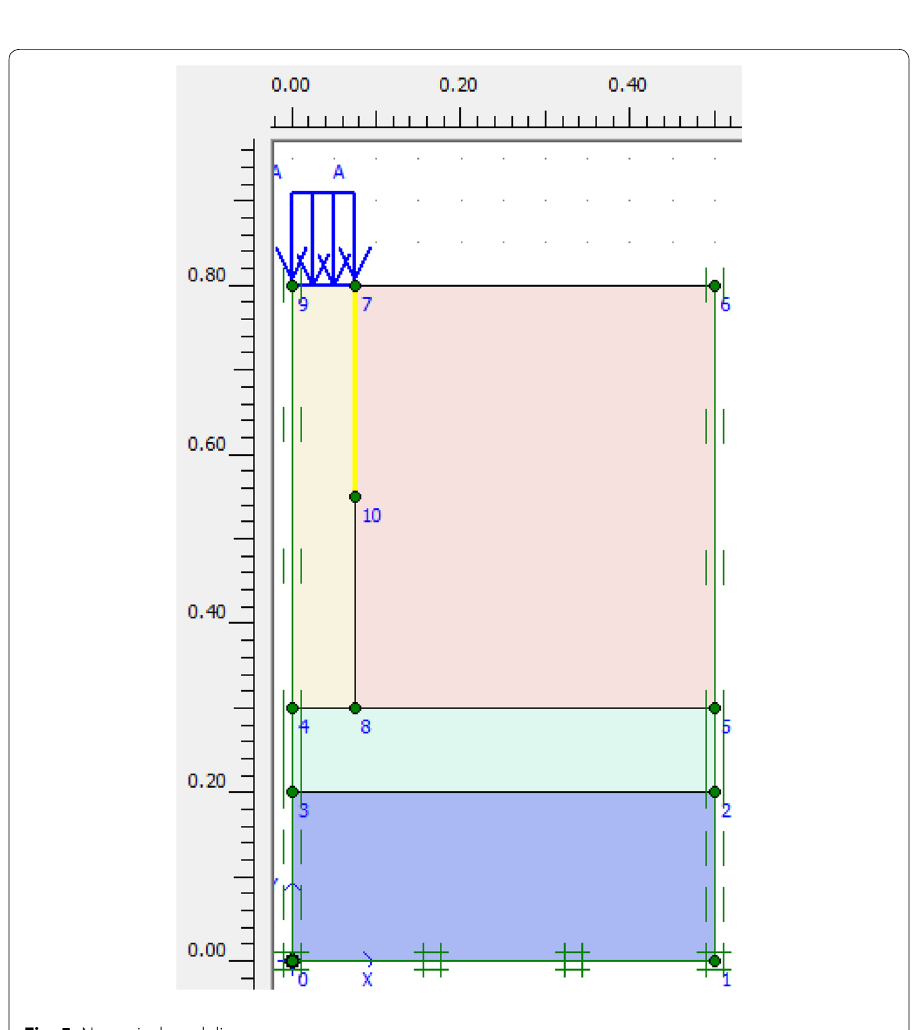
Fig. 5 Numerical